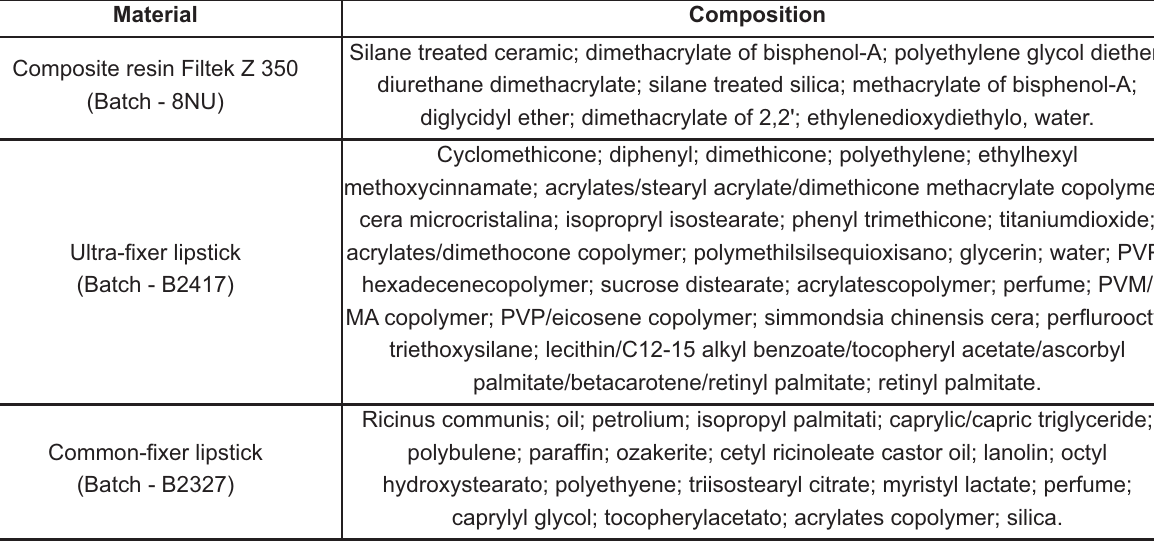
Figure 2- Composition and batch numbers of studied materials